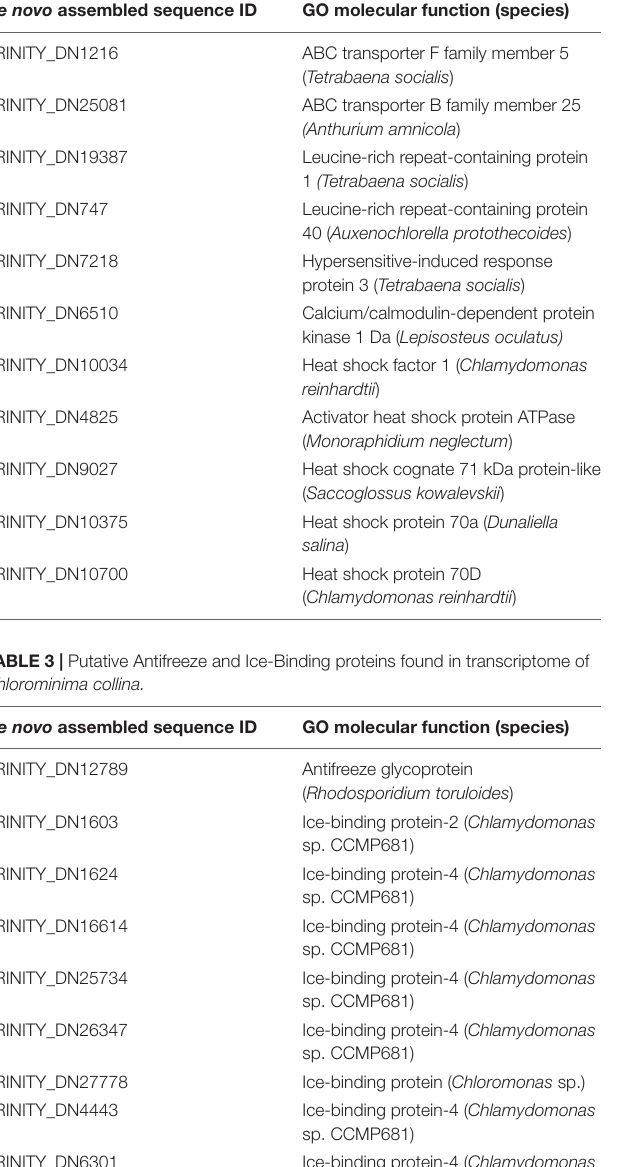
TABLE 4 | Putative desaturases and other enzymes involved in the biosynthesis of fatty acids, triacylglycerol and secondary carotenoids present in the transcriptome of Chlorominima